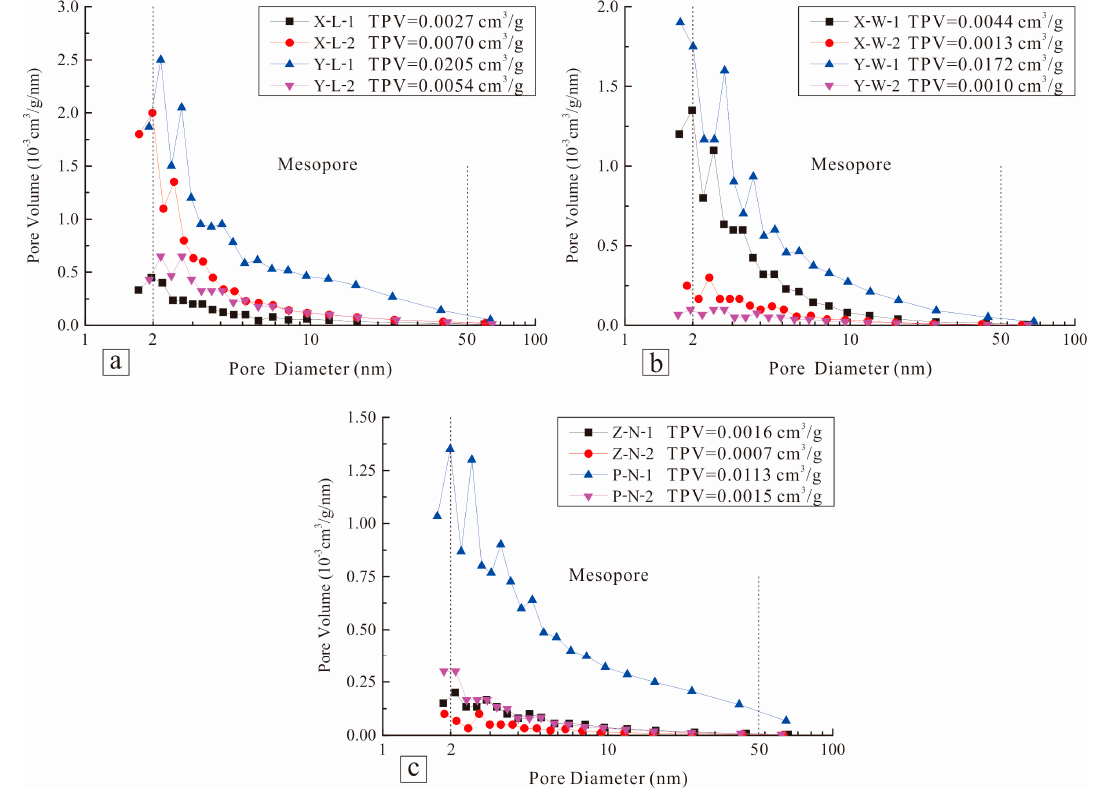
Figure 7. Plots of the pore size distribution (PSD) of collected samples derived from the N 2 adsorption experiments using the Barrett–Joyner–Halenda (BJH) model. TPV (total pore volume): ( a ) LSL shale; ( b ) UOW shale; ( c ) LCN